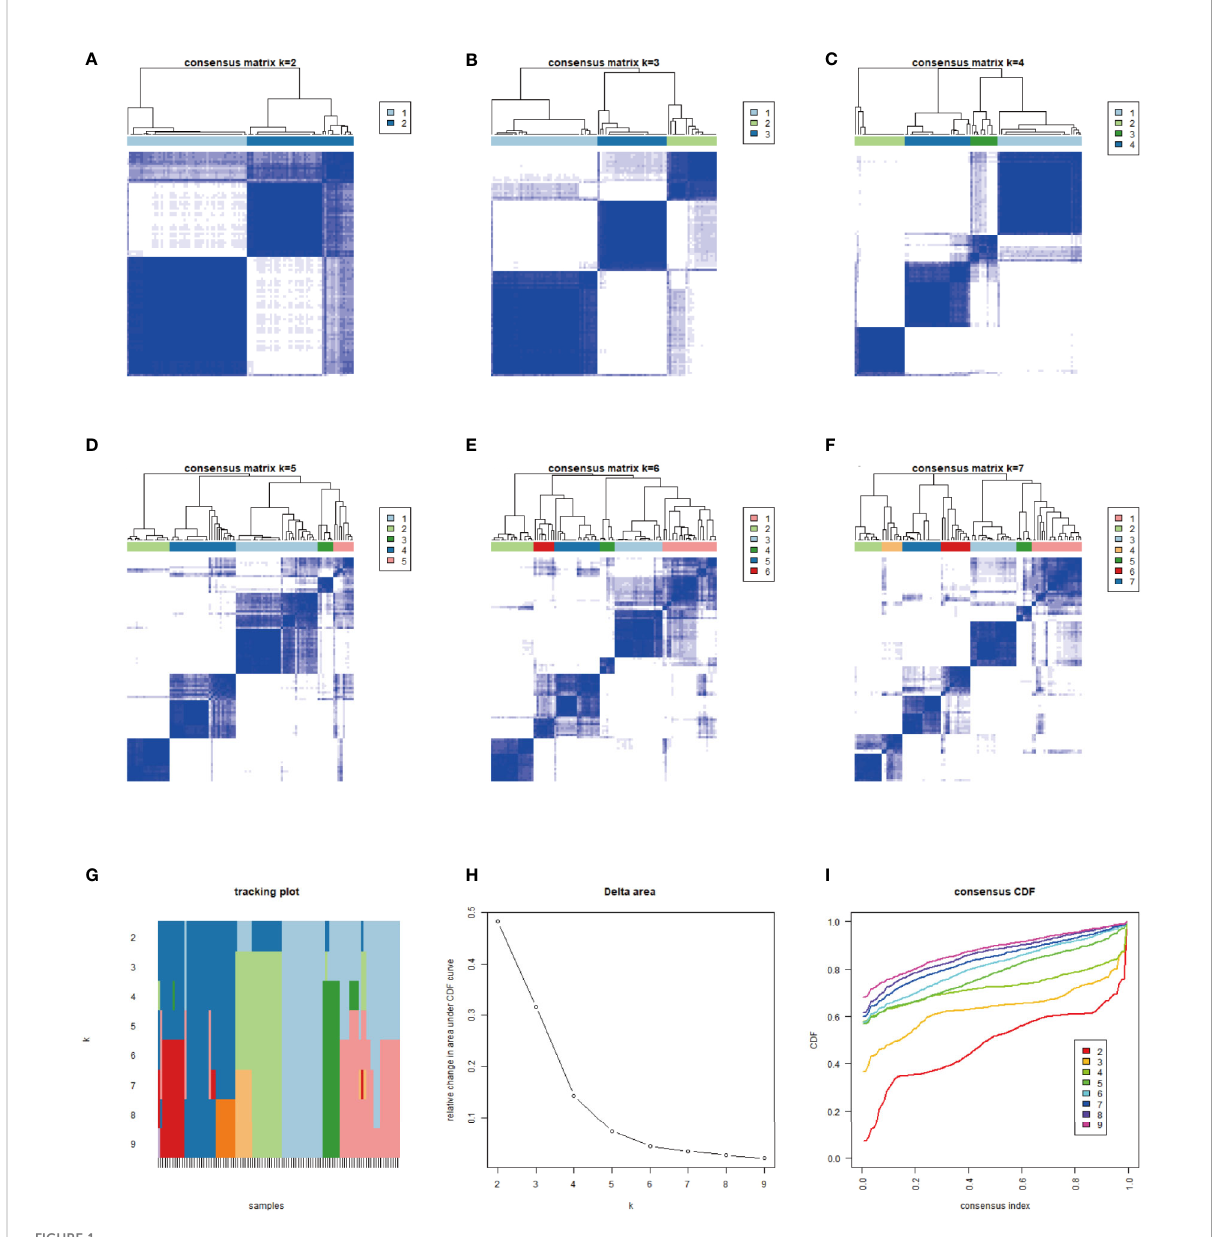
FIGURE 1 We typed 104 samples from the TCGA-MFS and GEO (GSM 72545) through CIBERSORT analysis. The samples were fi nally divided into 3 independent subtypes according to the stability of typing results. (A – F) represent the sample purity when the typing was 2 – 7: The blue square in the fi gure represents different classi fi cation aggregations. The darker the color and the smaller the number of blanks, the lower the difference in the aggregated samples and the higher the purity of typing. (G – I) re fl ect the purity of typing and the stability in the samples: (G) The abscissa is the sample, and the ordinate is the different classi fi cation, re fl ecting the stability between samples after different classi fi cation; (H) Cumulative Distribution Function (CDF) curve showing the sampling error in different classi fi cations; (I) Explanation of CDF curve, although the results of both analyses were better, we still chose 3 types in combination with (A – F)